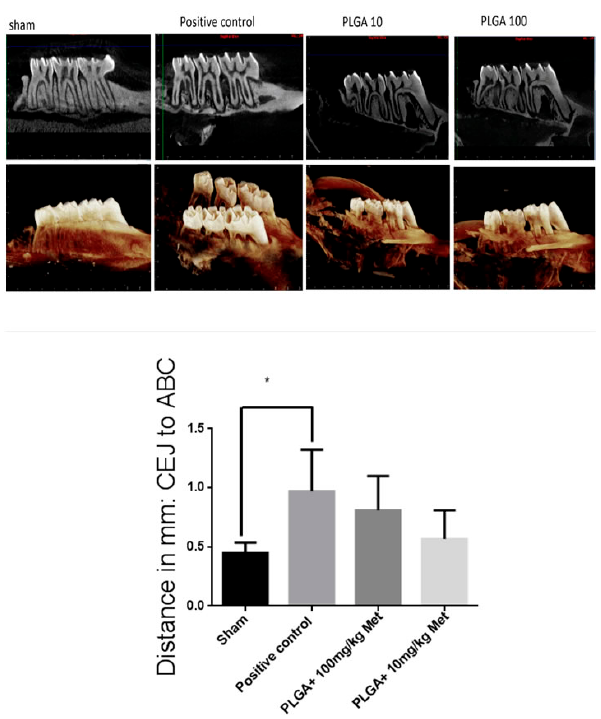
Figure 6. Radiographic evaluation after Met treatment and experimental periodontitis. Representative sagittal 2D and 3D microCT images of no ligature (Sham), ligature and diabetes mellitus (positive control), PLGA + 100 mg/kg Met, and PLGA + 10 mg/kg Met groups. Graph representing linear bone loss in the area of the mesial and distal second molar. Values are expressed as means ± SEM (compared to positive control * p < 0.05) (ANOVA test followed by Bonferroni).